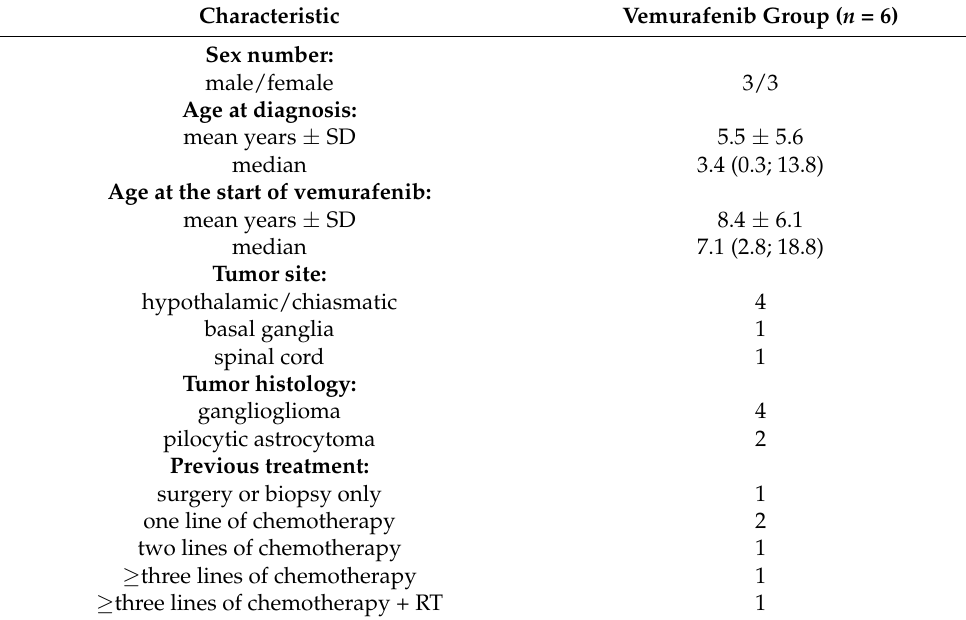
Table 1. Demographic and clinical features of the patients treated with